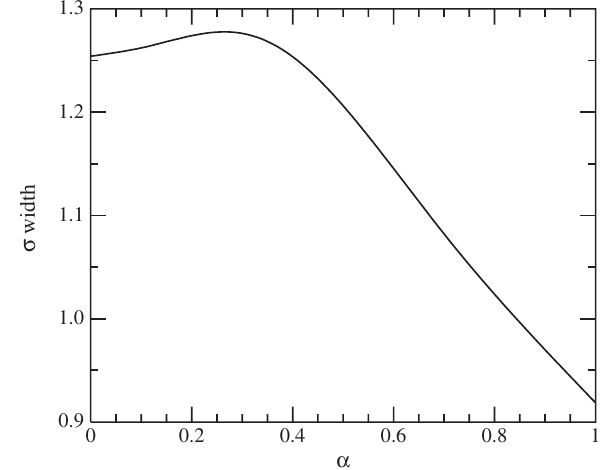
FIG. 15. Graph of the factor that converts values of a 2 to the time base of the measurements as a function of α